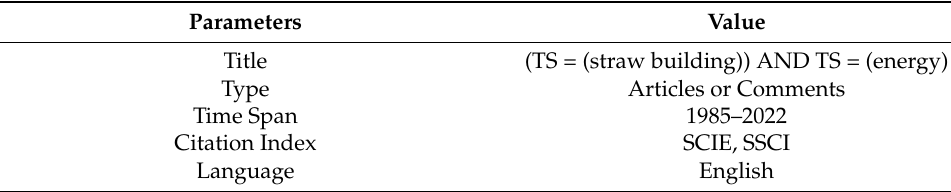
Table 1. Data parameters used for article